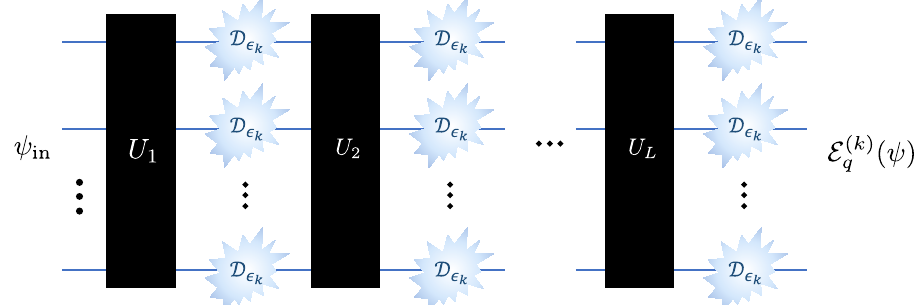
Fig. 4 Noise mitigation in layered circuits. Layered circuits are used extensively in variational algorithms for NISQ devices. They involve repeated layers of gates, each consisting of some unitary U l . A standard noise model for such circuits involves the action of local depolarizing noise D ϵ on each qubit during each layer of the circuit. The k th experiment in a general ( Q , K )-protocol involves running this circuit Q times to ð k Þ produce a distorted state (cid:6) Q ð ψ Þ with some noise strength ϵ k — which possibly varies over different experiments. The protocol then q ¼ 1 E q ψ Þ for k = 1, … , K and outputs an estimate E ð k Þ measures each (cid:6) Q A through classical post-processing of the measurements q ¼ 1 E q ð